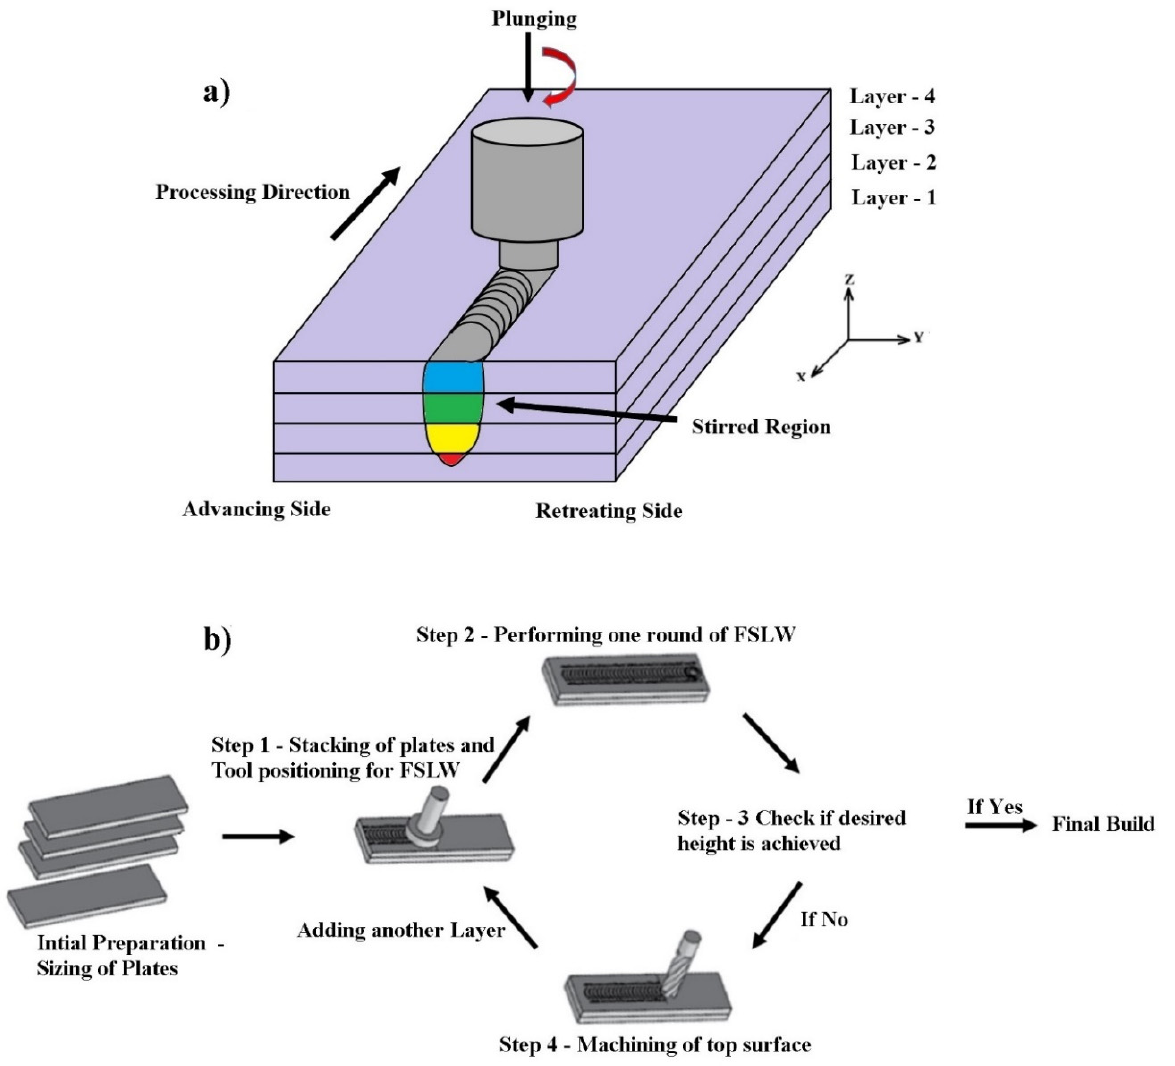
Figure 1. FSAM process: ( a ) Schematic representation of FSAM process and ( b ) steps in FSAM pro- cess.